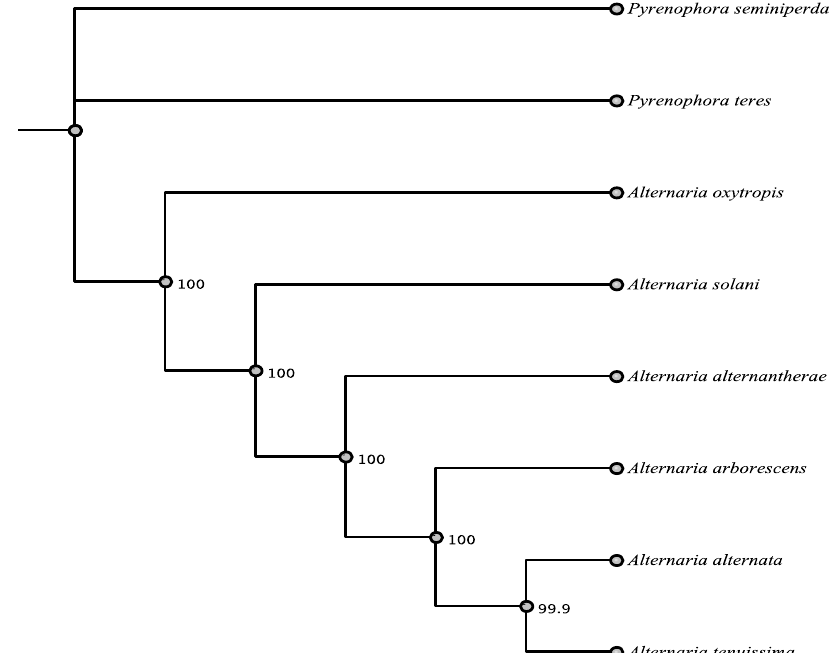
Figure 6. Maximum parsimony tree (MUSCLE alignment and 1000 replicates). Pyrenophora semini- perda was used as the outgroup. Fungi in tree are pblast results of 8407 sequence.